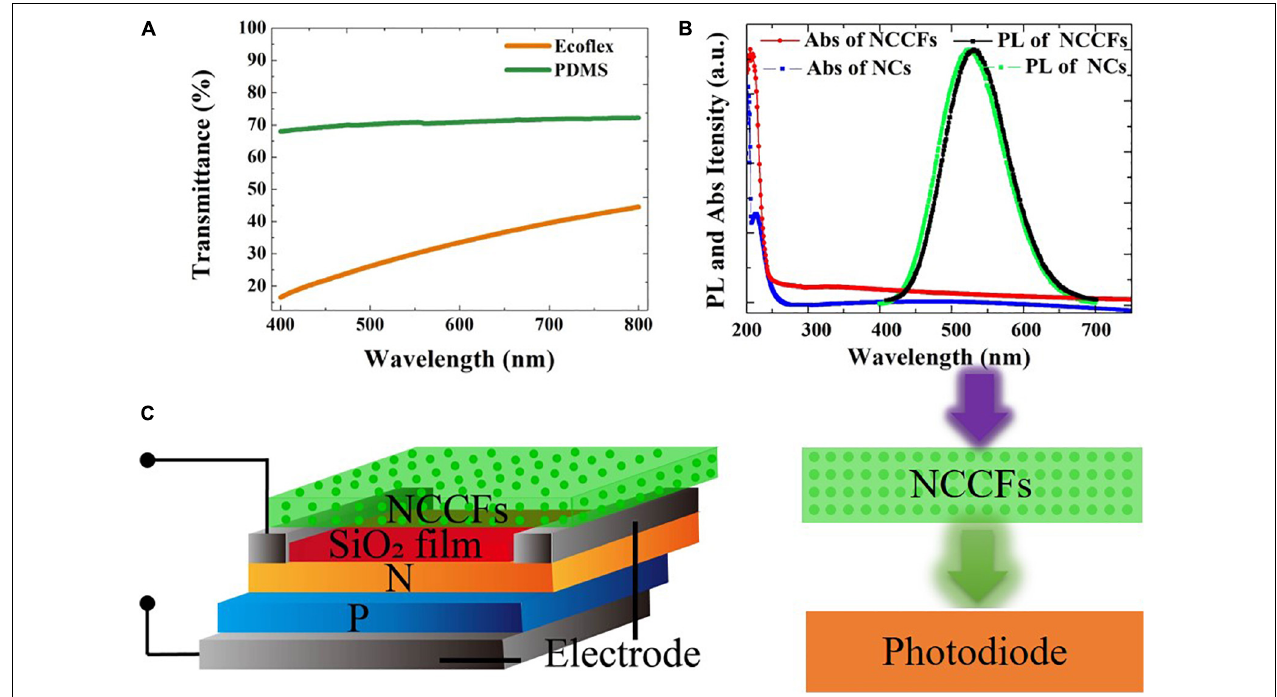
FIGURE 3 | (A) Transmittance spectra of the Ecoflex and PDM. (B) Abs spectra and PL spectra of Cs 3 Cu 2 Cl 5 NCs and NCCFs. (C) Schematic diagram of the configuration of the UV-enhanced Si photodiode and the down-conversion process of